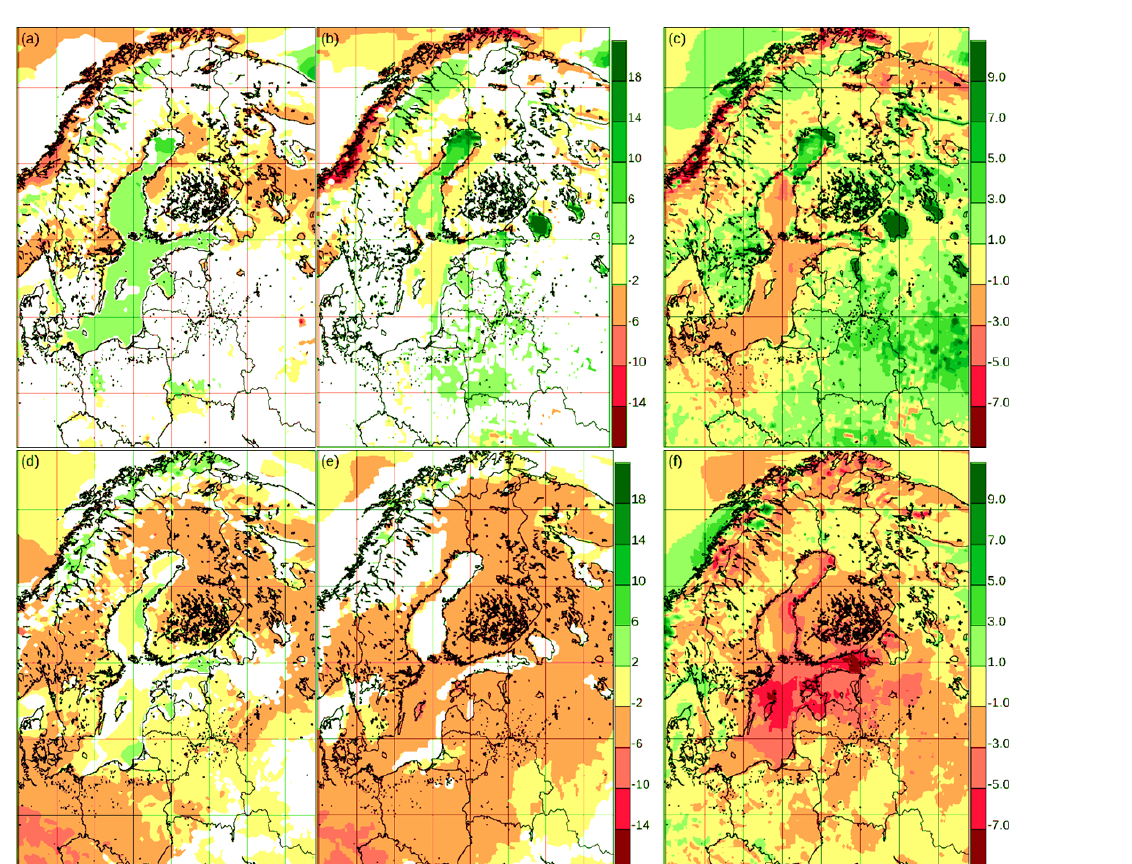
Figure 12. Average wind speed relative change (%) between 1981–2010 and 2071–2100 for five atmosphere-only RCA4 simulations from EURO-CORDEX according to the RCP8.5 scenario (a, d) and for the coupled single-model RCA4-NEMO ensemble with the same driving GCMs (c, f) ; pointwise median values, only coloured when 75% of simulations agree on the sign of the change. Difference between the two ( c , f ; coupled minus uncoupled; %). (a–c) Winter; (d–f)